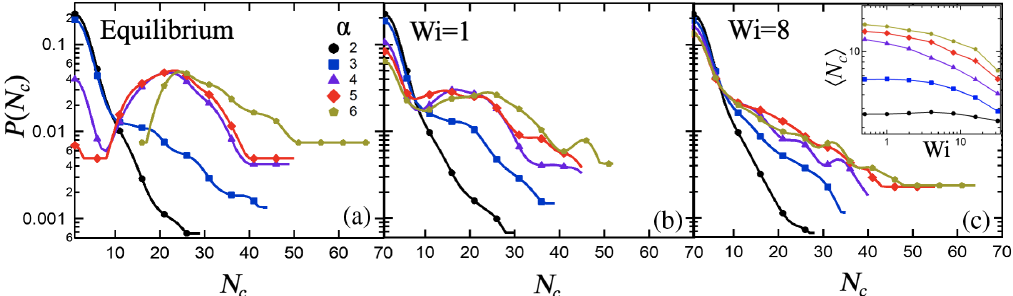
Þ as a function of cluster size N FIG. 5. Probability P ð N for interaction ratio α ¼ 2 – 6 , (a) at equilibrium, (b) for Wi ¼ 1 , and c c i as a function of Wi for corresponding systems. (c) Wi ¼ 8 . The inset shows the average cluster size h N c